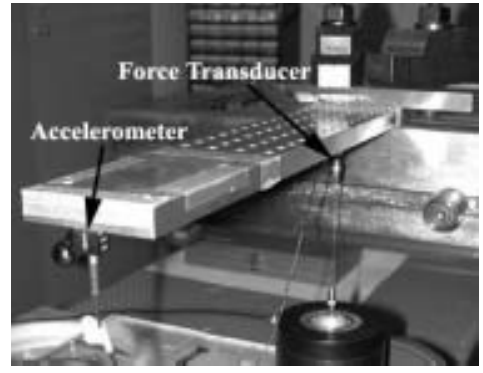
Fig. 3. Photo of beam test setup.